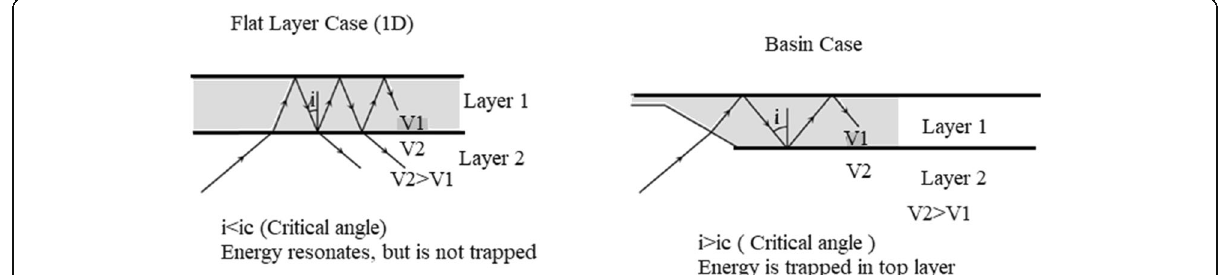
Fig. 5 Propagation of seismic wave on one layer soil and basin case (Vittoz et al.